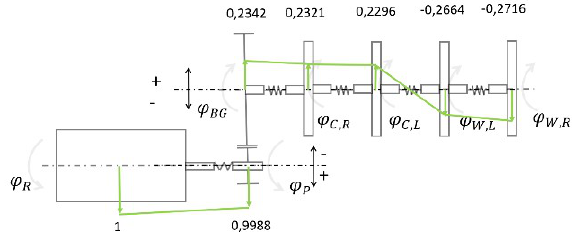
Figure 11. Second natural mode of torsion oscilla- tions [3].